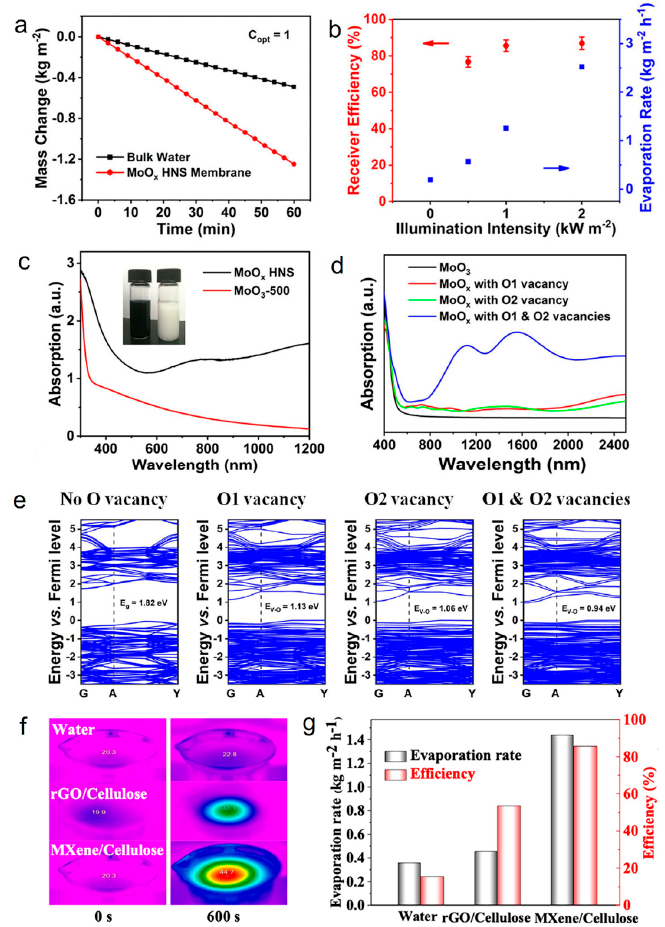
Figure 2. ( a ) Mass change of bulk water and water covered with different MoO x HNS membranes under one sun. ( b ) The evaporation rate and corresponding receiver efficiency of the MoO x HNS membrane under different illumination intensities. ( c ) UV − Vis − NIR absorption spectra of the MoOx HNS and MoO 3 − 500 (The MoO 3 sample was treated via air-oxidation at 500 °C). Inset: optical photos of MoOx HNS (left) and MoO 3 − 500 (right) aqueous solutions. ( d ) Simulated optical absorption spec- tra. ( e ) Simulated band structures of the molybdenum oxides with different concentrations of oxy- gen vacancies. Reprinted with permission from ref. [49]. Copyright 2019 Wiley-VCH. ( f ) IR thermal images of bulk water, MXene/cellulose, and rGO/cellulose membrane surface. ( g ) Water evapora- tion rates and solar steam efficiency of bulk water, rGO/cellulose, and MXene/cellulose membranes under the solar illumination of 1 sun. Reprinted with permission from ref. [51] . Copyright 2019 American Chemical Society.